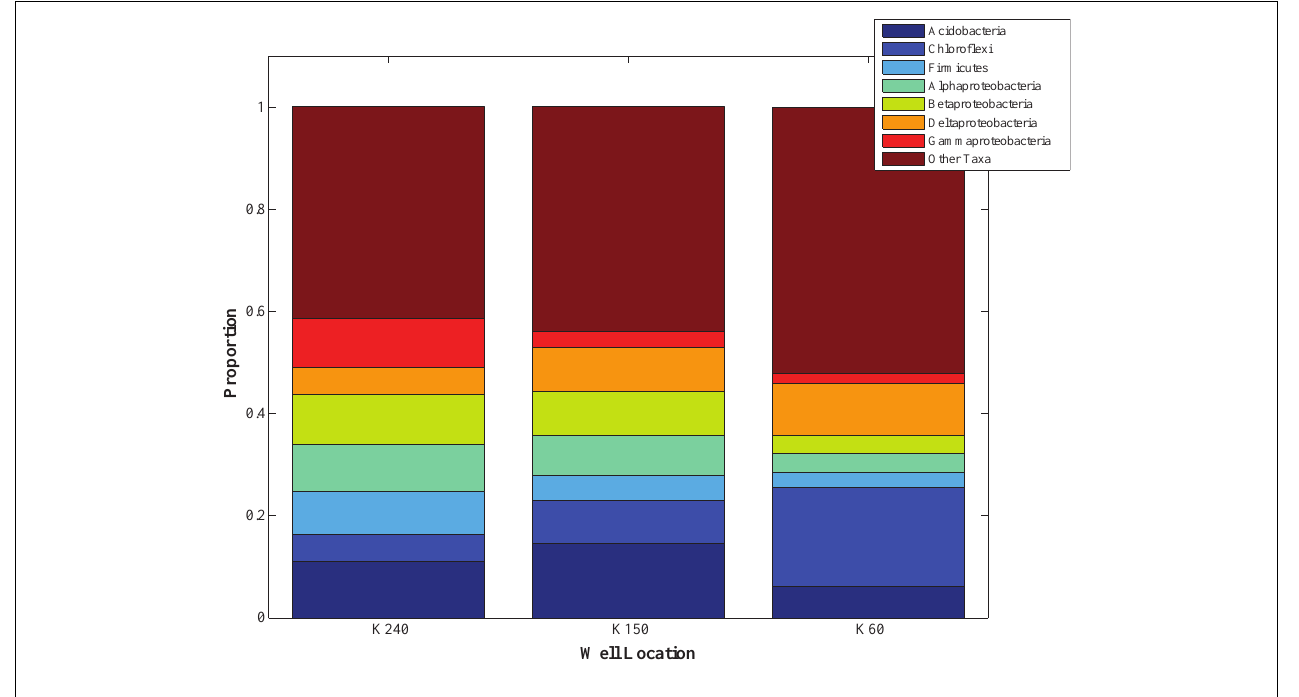
FIGURE 4 |The bacterial communities, as characterized by the UniFrac metric, are significantly distinct at the three well locations at our study site (PERMANOVA, R 2 = 0.23; p ≤ 0.001). The bar graphs show the relative abundances of dominant ( > 5% total abundance) bacterial taxa at